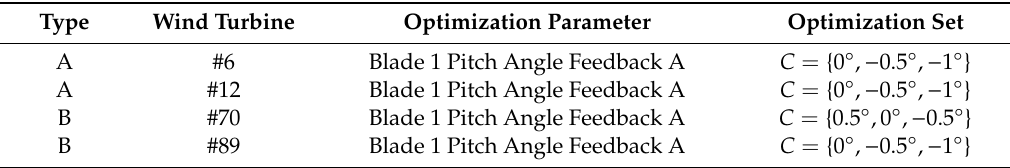
Table 6. Description of optimization parameter and optimization set.